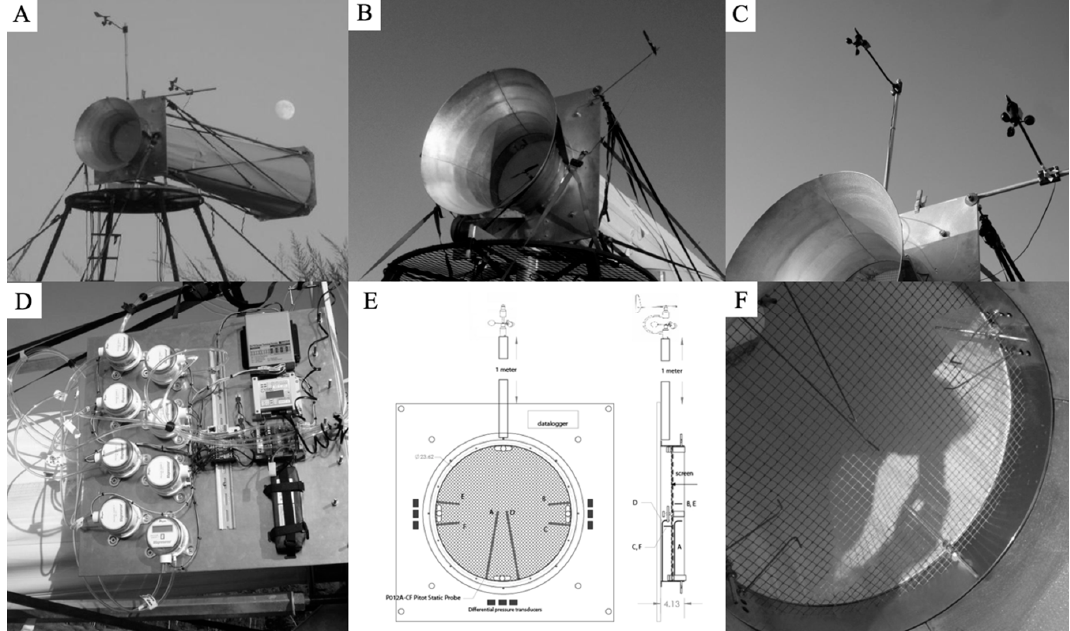
Figure A3. ( A ) Accelerator Field Experiment, ( B ) Rotor anemometer velocity measurement, ( C ) Anemometers 1m above and to the right of the accelerator, ( D ) Instrumentation panel on side of prototype, ( E ) Diagram of Prandtl tube arrangement in the accelerator, ( F ) Prandtl Tubes installed with a 24% solidity screen in the throat of Accelerator.